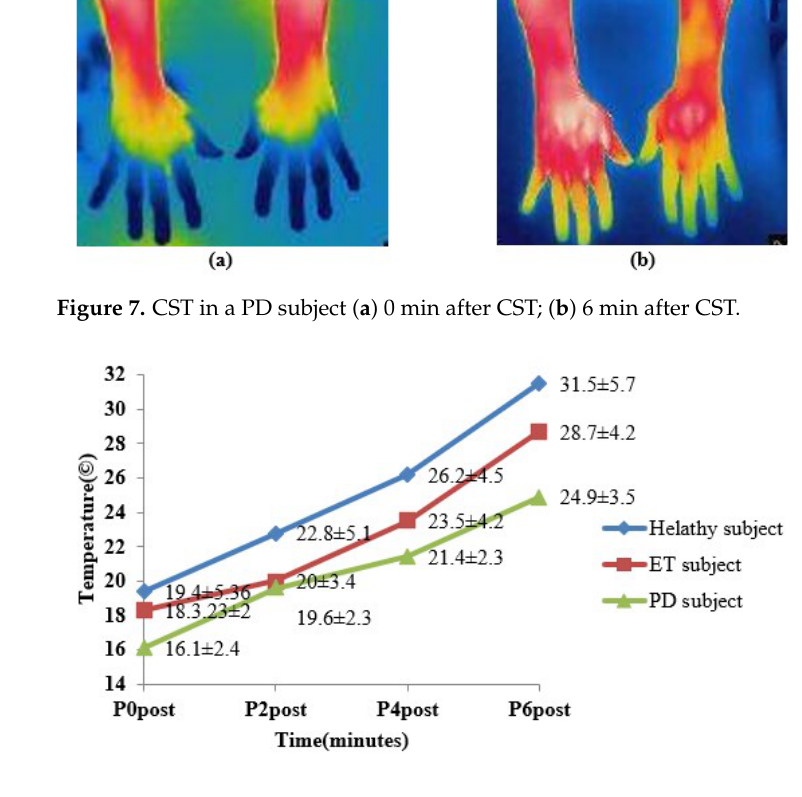
Figure 8. Comparison of cold stress test in healthy, ET and PD subjects.